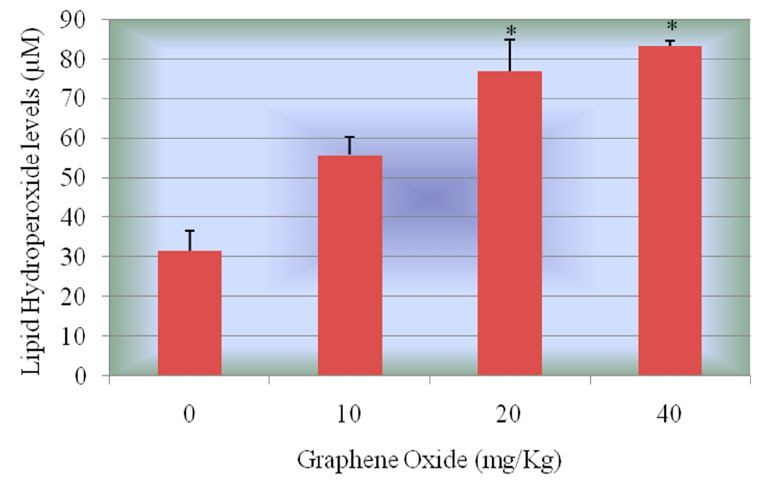
Figure 9. Effect of GOs on LPO activities in kidneys of rats after 5 days. Each bar represents mean ˘ SD Figure 10 of five rats. Values with asterisks were significantly different from control. Statistical significance ( p < 0.05) is depicted as ( * ).